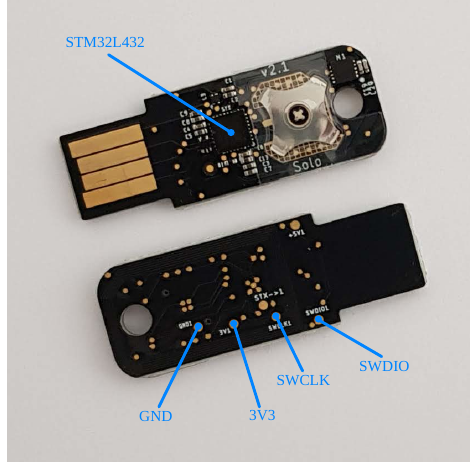
Figure 4: Front (top) and back side (bottom) of the SoloKeys Solo. The integrated microcontroller and the accessible supply and debug pins are